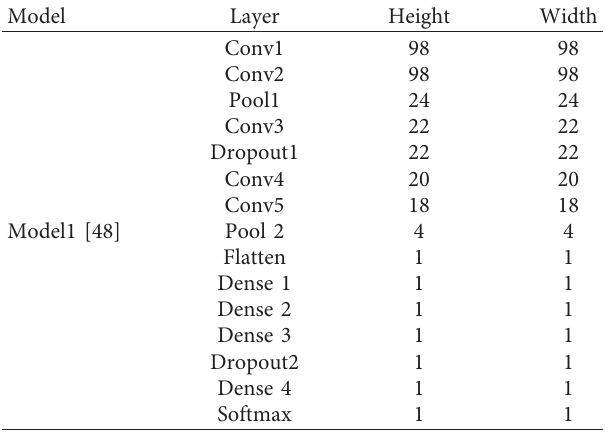
Table 1: Layer dimensions and operations. Model